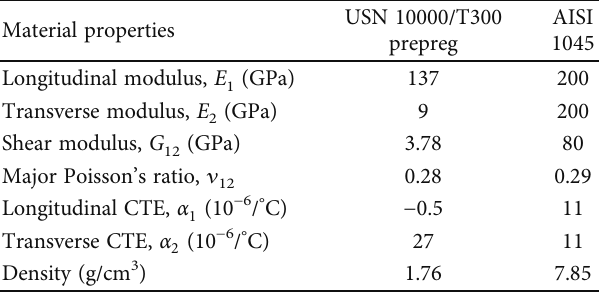
Table 2: Material properties of the unidirectional CFRP composite and the steel square